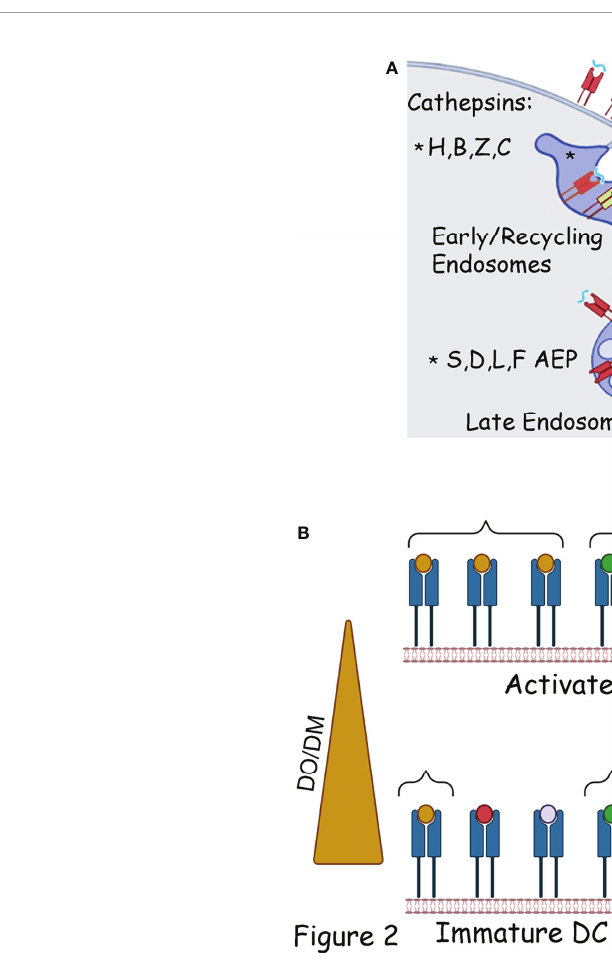
FIGURE 2 | Chaperones and organelles involved in the generation of the MHC II ligandome. (A) Endopeptidases (*) present in early and late endosomes, involved in the generation of the MHC II ligandome. In early endosomes the processed peptides will be loaded on MHC II molecule recycling from the plasma membrane. Peptide can also load directly at the cell surface on empty MHC II molecules or in exchange for low af fi nity peptides. In late endosomes the processing enzymes are located in the lumen of the compartment, outside the vesicles. MHC II molecules are anchored to the vesicles limiting membrane and exposed to the processed peptides. DM is mostly located on the endosomal limiting membrane. As such optimal DM activity is generated during in fl ammation-mediated endosomal tubulation, which transport MHC II at the cell surface. (B) In immature DC, or non-activated B cells, DM activity is inhibited by DO, as such the MHC-II ligandome contains a broad and diverse peptide spectrum, comprises of both low and high af fi nity peptides and with some empty and MHC-II-CLIP complexes at the cell surface. This MHC-II ligandome facilitate tolerance (Bottom panel) Following DCs and B cell activation the decreased DO activity allows DM to select a more focused, and high af fi nity MHC-II ligandome to facilitate immunity (Top panel). Braces indicates MHC II molecules in the top and bottom panels, loaded with the same